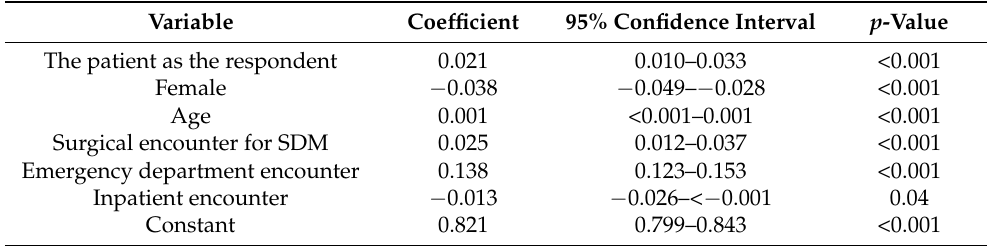
Table 6. Multivariate linear regression analysis for the feedback evaluation standardized score for the SDM process ( n = 3049). Variable Coefficient 95% Confidence